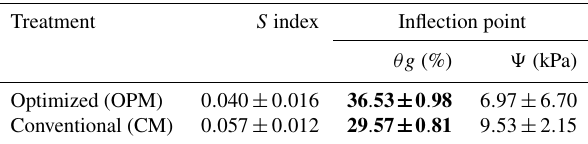
Table 3. S -index values and contents of water ( θ ) and suction ( (cid:57) ) corresponding to the inflection point, obtained with the sigmoidal equation adjusted to experimental data. Mean ± standard deviation of the mean ( n = 3). Statistically significant differences ( p < 0 . 05) are in